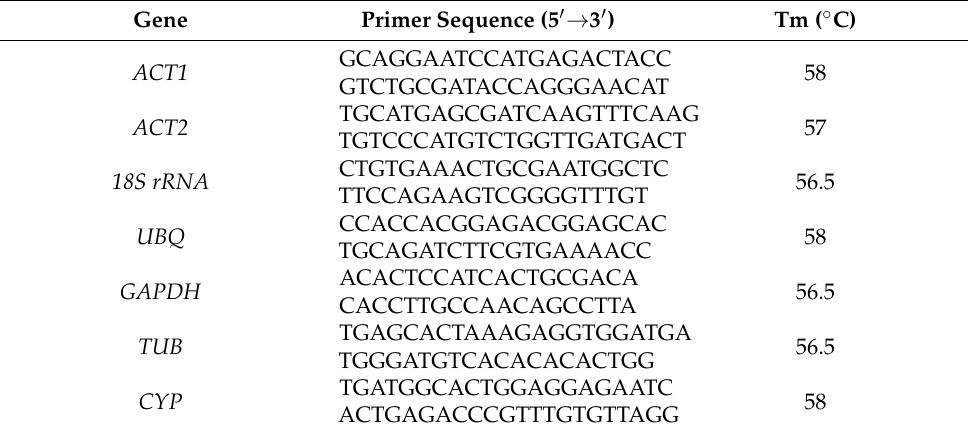
Table 1. Primer sequences of candidate reference genes used for qRT-PCR analysis. Gene Primer Sequence (5 (cid:48) → 3 (cid:48)